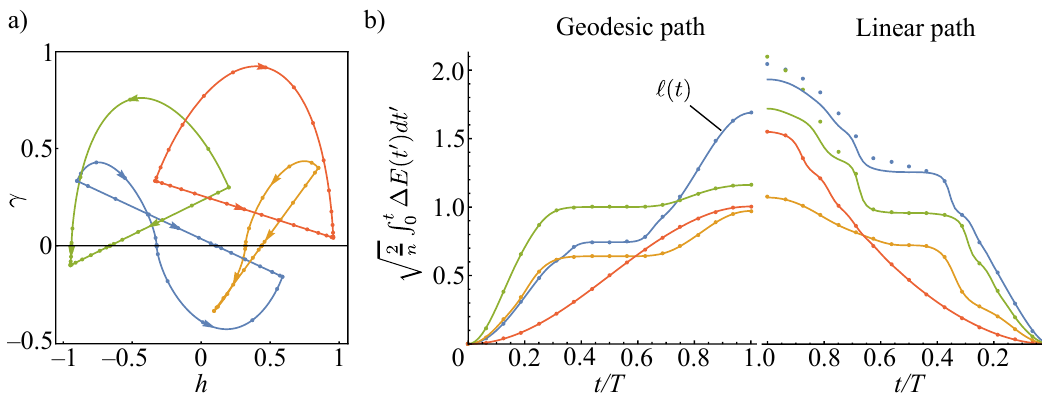
Figure 4: Numerical simulations of different Adiabatic protocols over a finite time T = 100 n . a) For each color there are two adiabatic protocols: one following a linear path and one following a geodesic path in parameter space. The number of spins in each simulation is n = 35,12,25,30 for the blue, orange, green and red curves respectively. Each dot in the path is separated by T / 16 units of time and the protocol is such that it slows down at the initial, critical and final parameters. b) The points represent the integral over energy fluctuations with respect to time. The solid line is the length of the path (cid:96) ( t ) given by the Fubini-Study metric. The normalization in the energy variations allows us to compare protocols with different number of